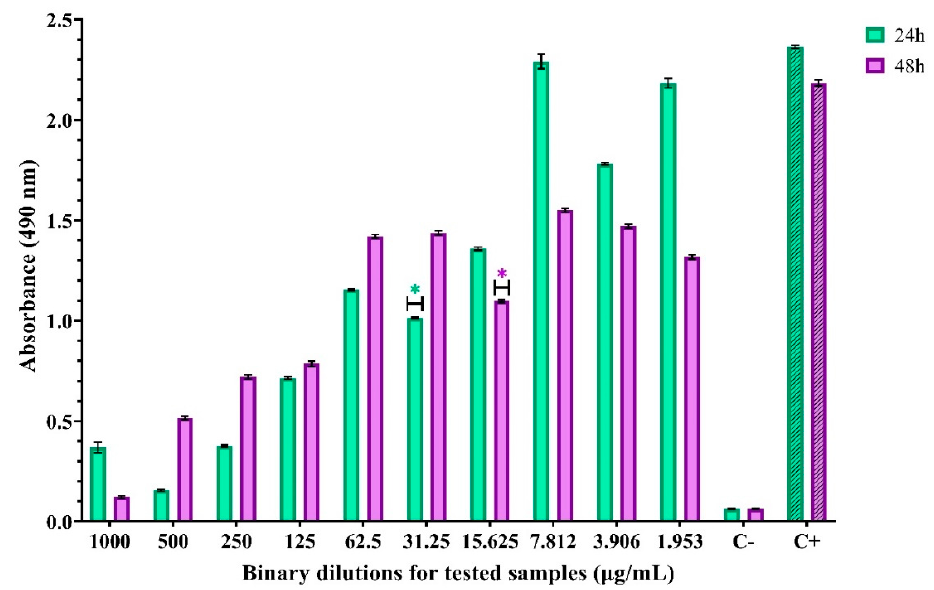
Figure 11. Absorbance values for evaluation of anti-adhesion activity for ZnO nanoparticles against C. albicans . * indicates the MBEC values and differences between groups are considered statistically significant ( p < 0.001).